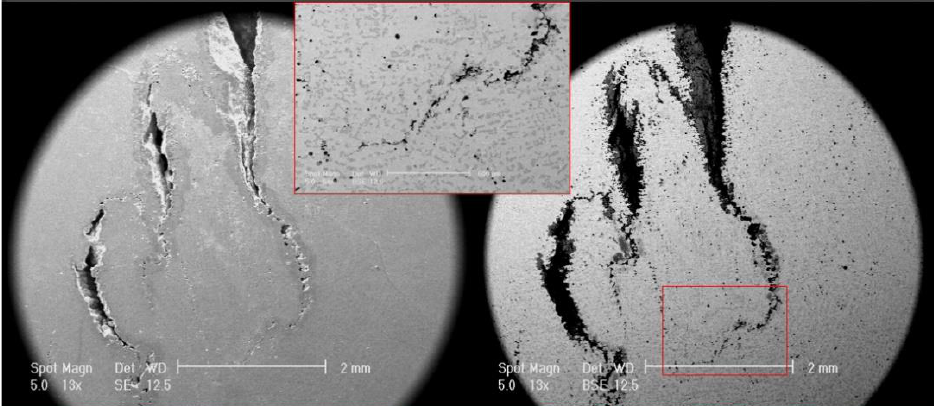
Figure 12. SEM images of cracked regions; directional creep pores are seen along the length of main cracks. The singular creep pores have a uniform distribution in the matrix. cracks. The singular creep pores have a uniform distribution in the